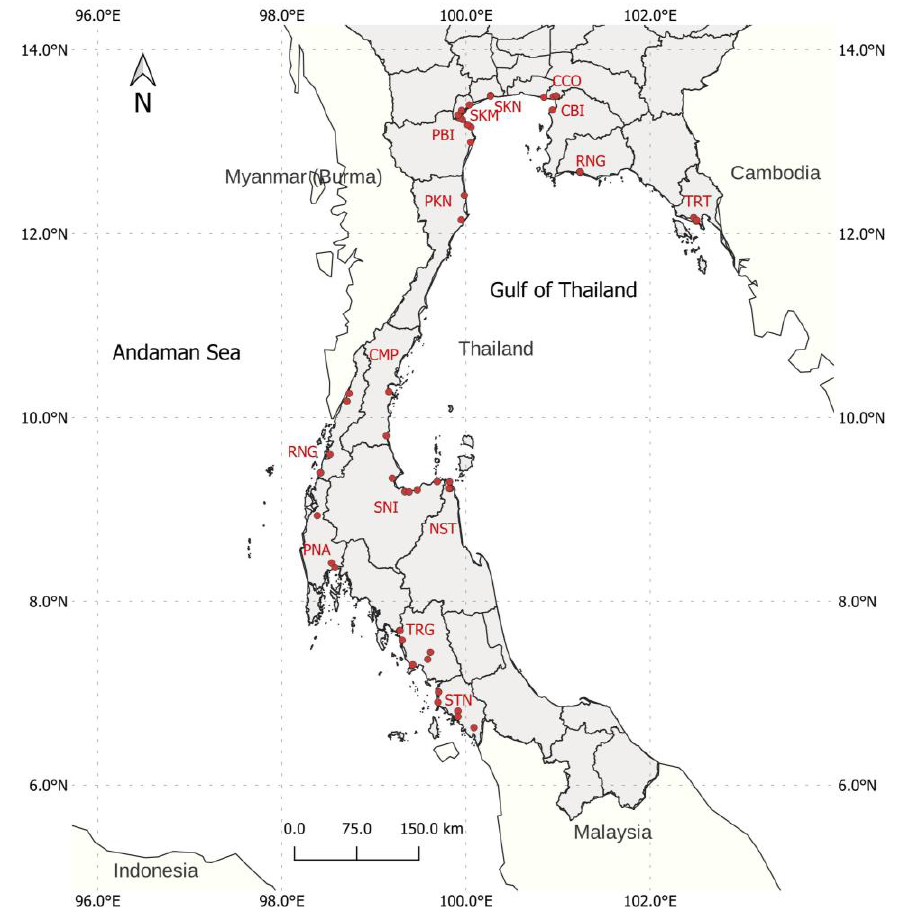
Figure 1. Geographical locations of 73 B. gymnorhiza (L.) Savigny accessions in Thailand. Red dots and texts represent sampling sites and abbreviations for provinces, respectively.